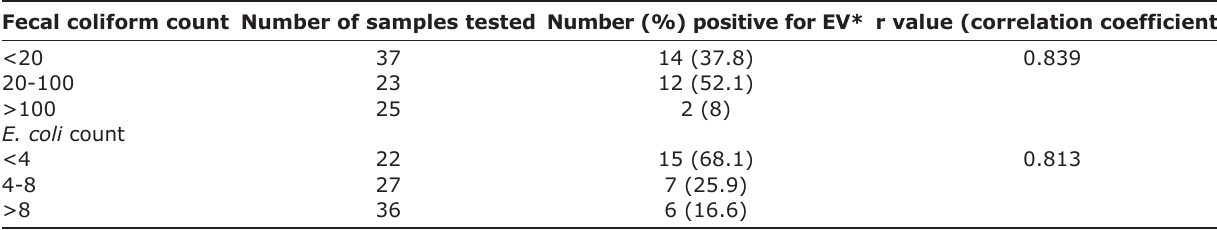
*Based on the detection of viral nucleic acid. EV=Enterovirus Table-2: Relationship between fecal coliform load and the incidence of enteric viruses in seafood